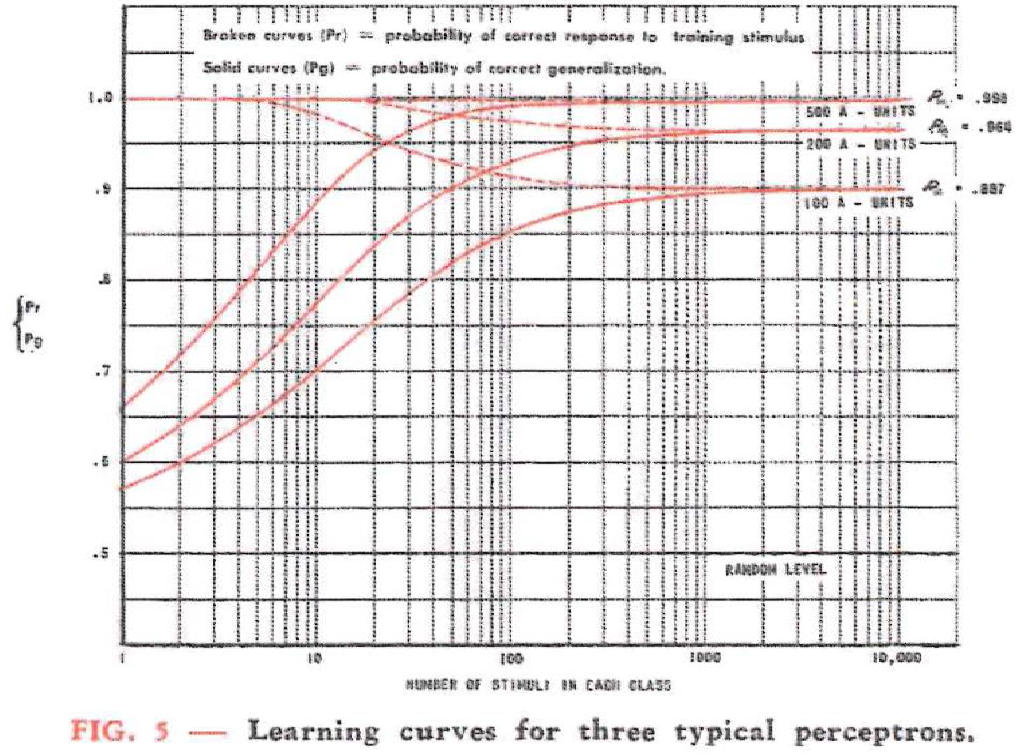
Figure 7. Learning curves for three typical perceptrons [16] (p. 6).